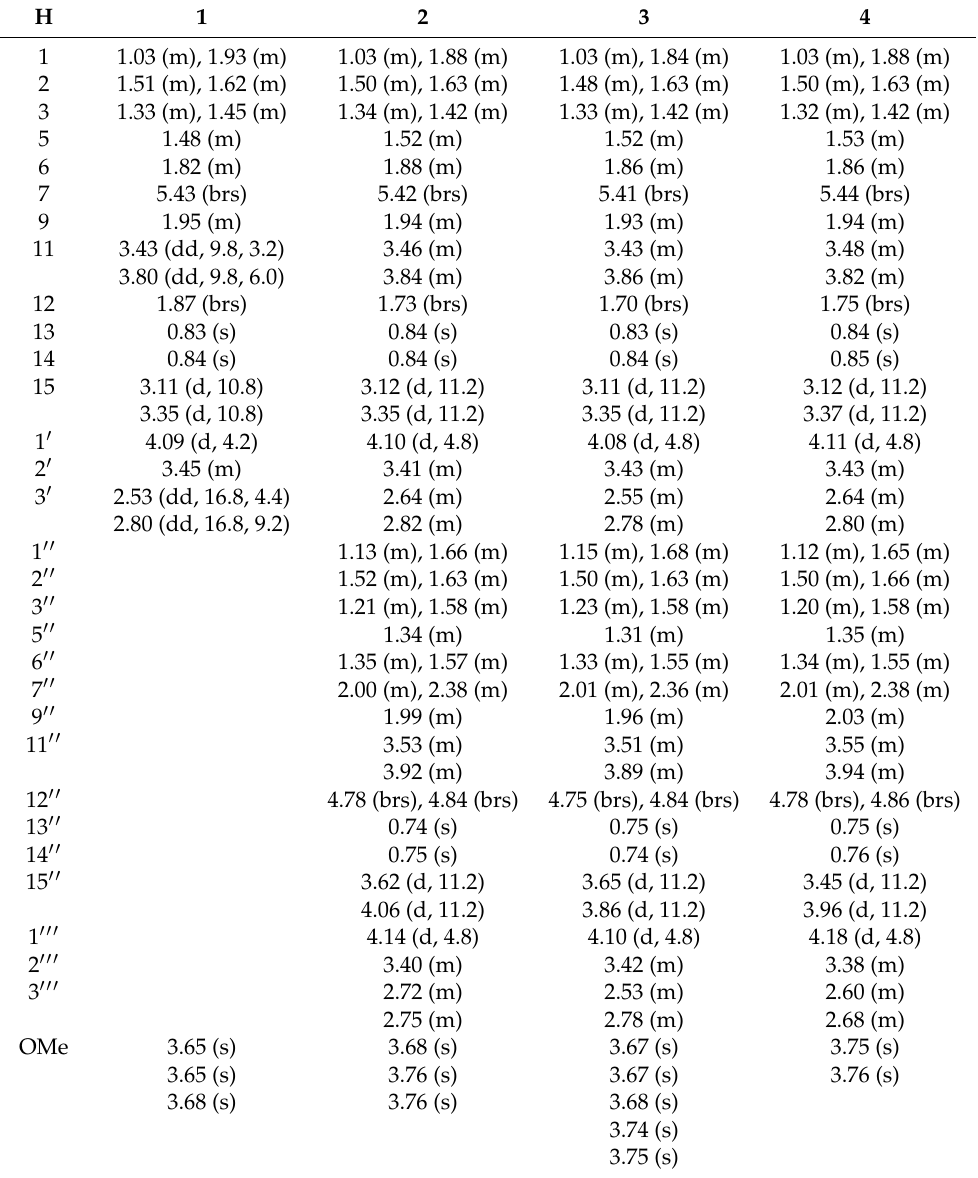
Table 1. The 1 H-NMR spectral data for compounds 1 – 4 (500 MHz, CDCl 3